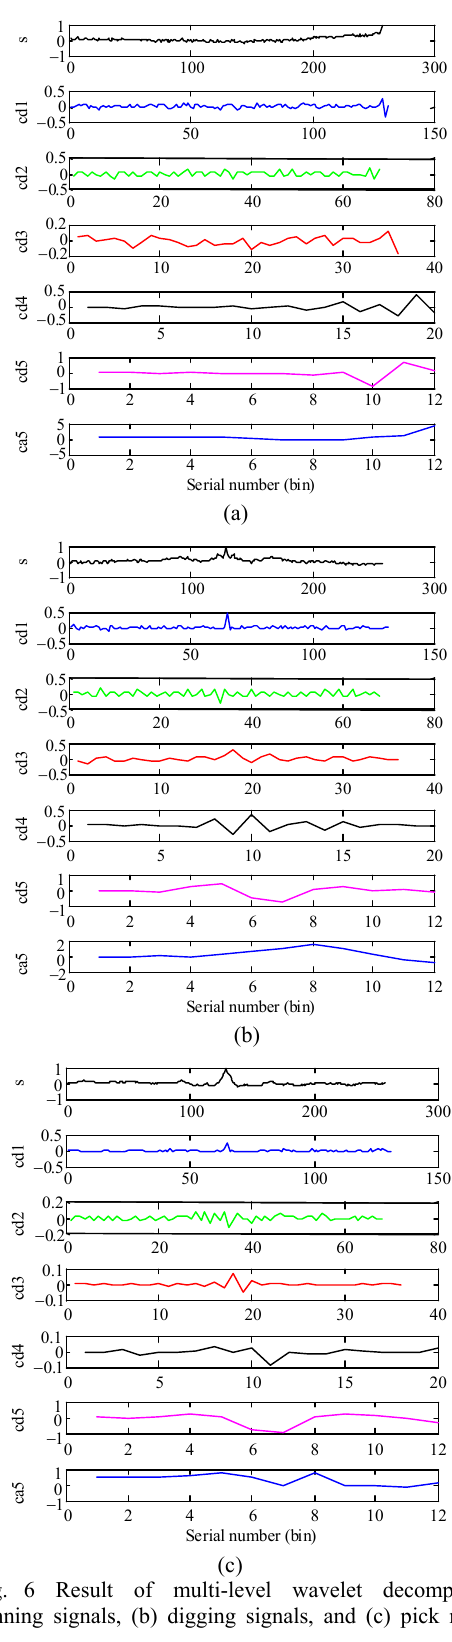
Fig. 5 Original waveforms of vibration signal: (a) running signals, (b) digging signals, and (c) pick mattock signals.